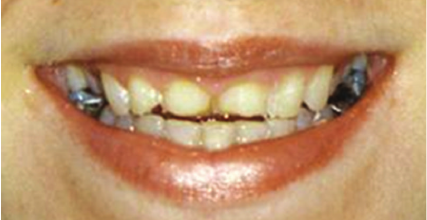
Figure 6: Photograph of a female patient with erosion caused by bulimia.